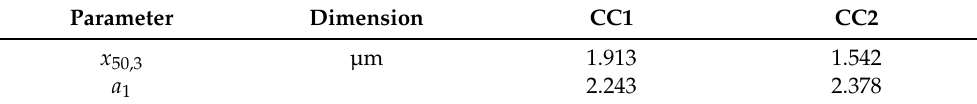
Table 3. Fit parameters of particle size distribution for the two calcium carbonate products.